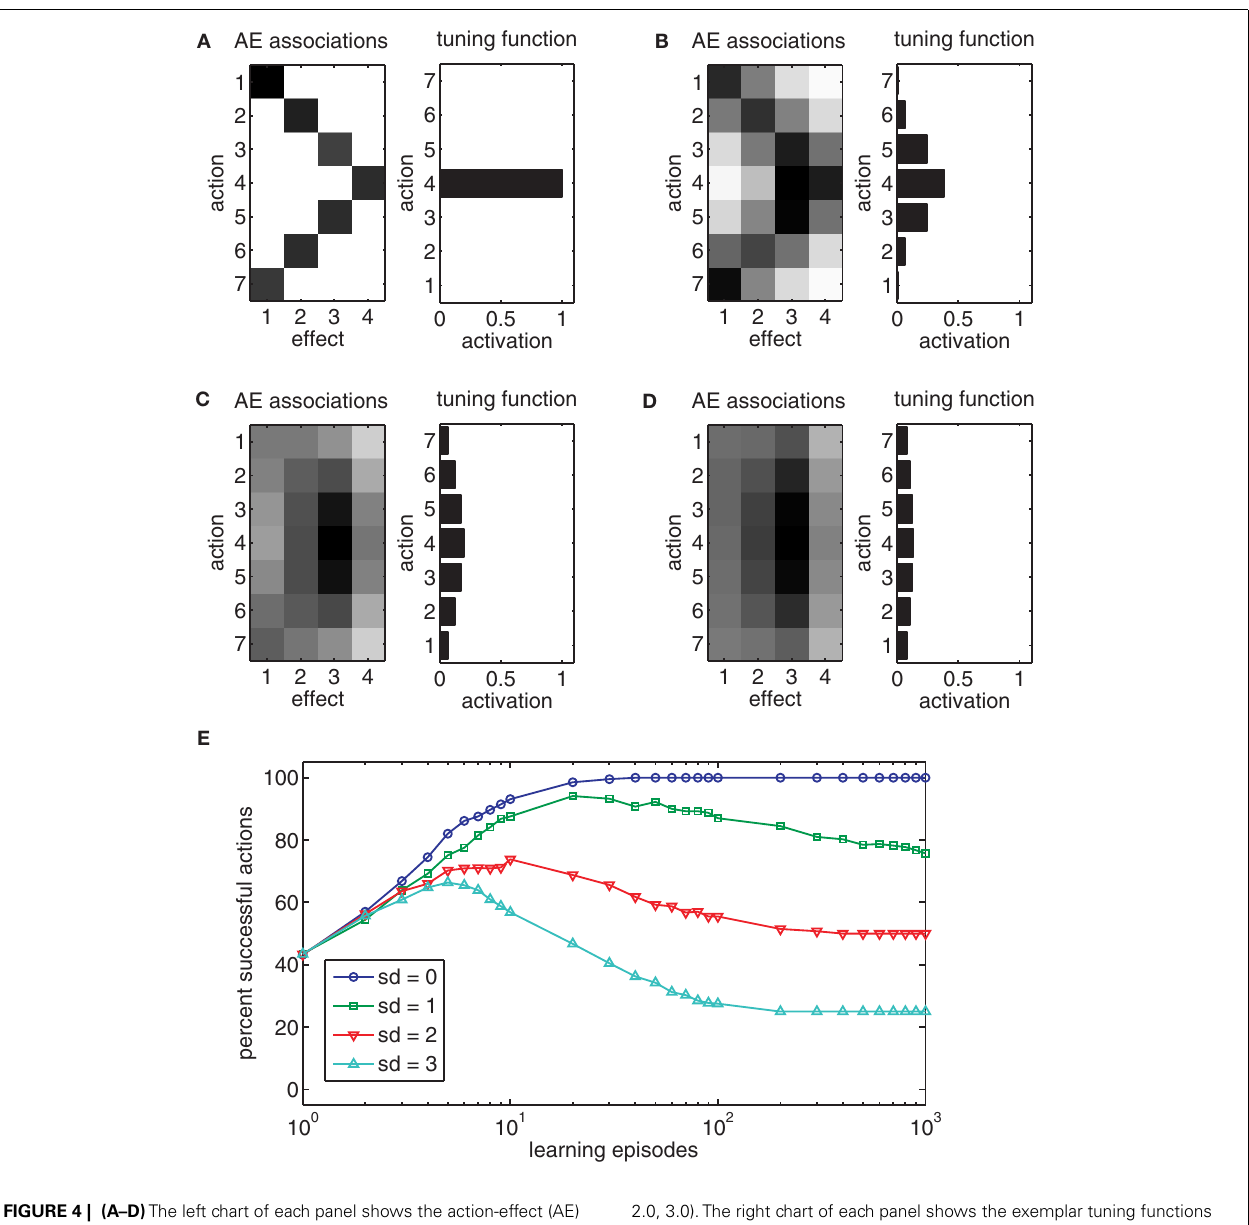
FIGURE 4 | (A–D) The left chart of each panel shows the action-effect (AE) associations after 1000 episodes (darker squares indicate stronger associations) with different Gaussian action turning functions (SD = 0.0, 1.0,